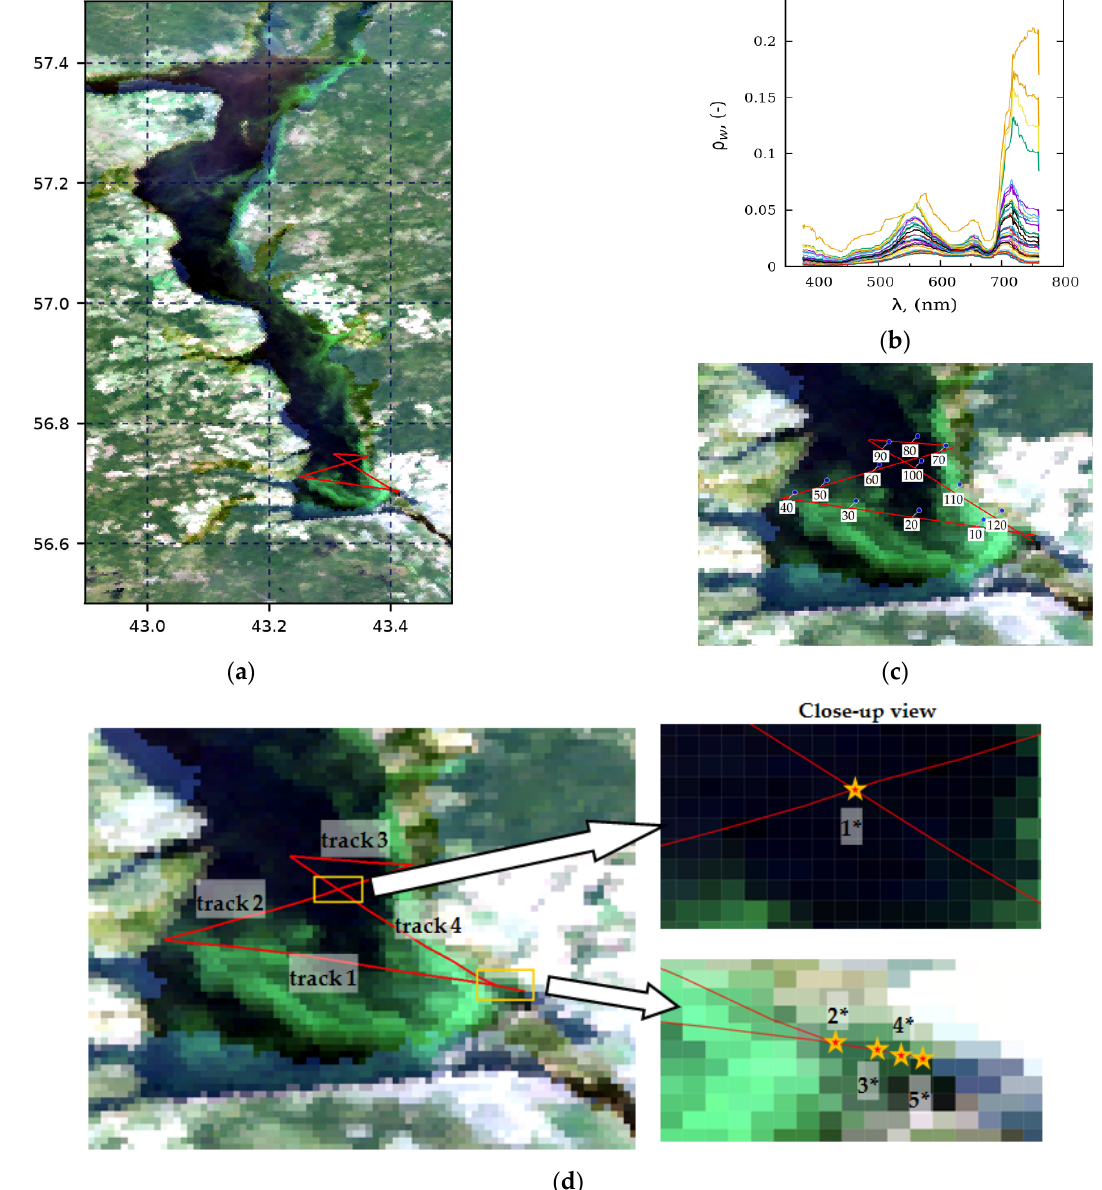
Figure 5. ( a ) RGB image (the surface reflectance in the bands of 665, 560, and 490 nm) of the Gorky Reservoir on 22 September 2018, ( b ) examples of measured water-leaving reflectance spectra (color lines), ( c ) map of some match-up pixels where OLCI R rs estimates were validated, and ( d ) arrange- ment of the pixels (star marks) and its designation (a number with * symbol) used to estimate the temporal variability of remote sensing reflectance. Red lines are the motorboat tracks. The yellow rectangles represent the zoomed areas on the right.